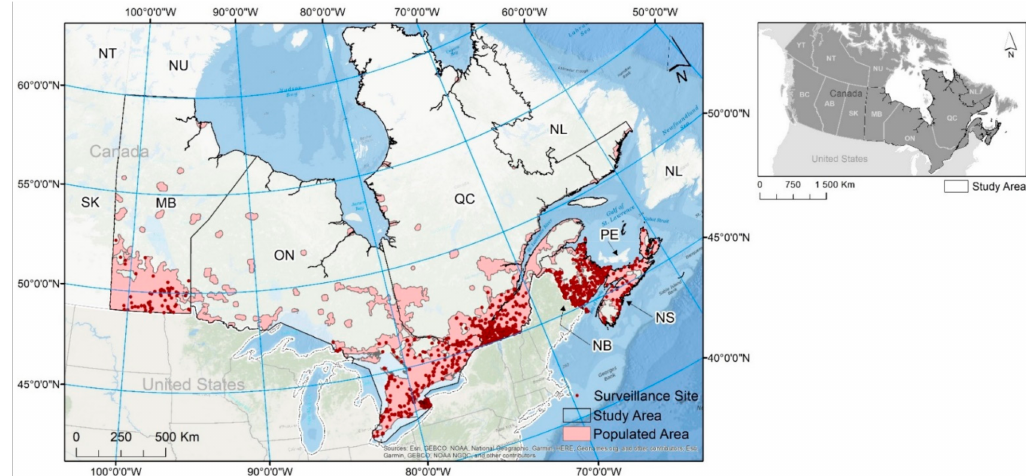
Figure 1. Study area showing tick surveillance sites. Abbreviations: MB, Manitoba; NB, New Brunswick; NL, Newfoundland and Labrador; NS, Nova Scotia; NT, Northwest Territory; NU, Nunavut; ON, Ontario; PEI, Prince Edward Island; QC, Quebec; SK,